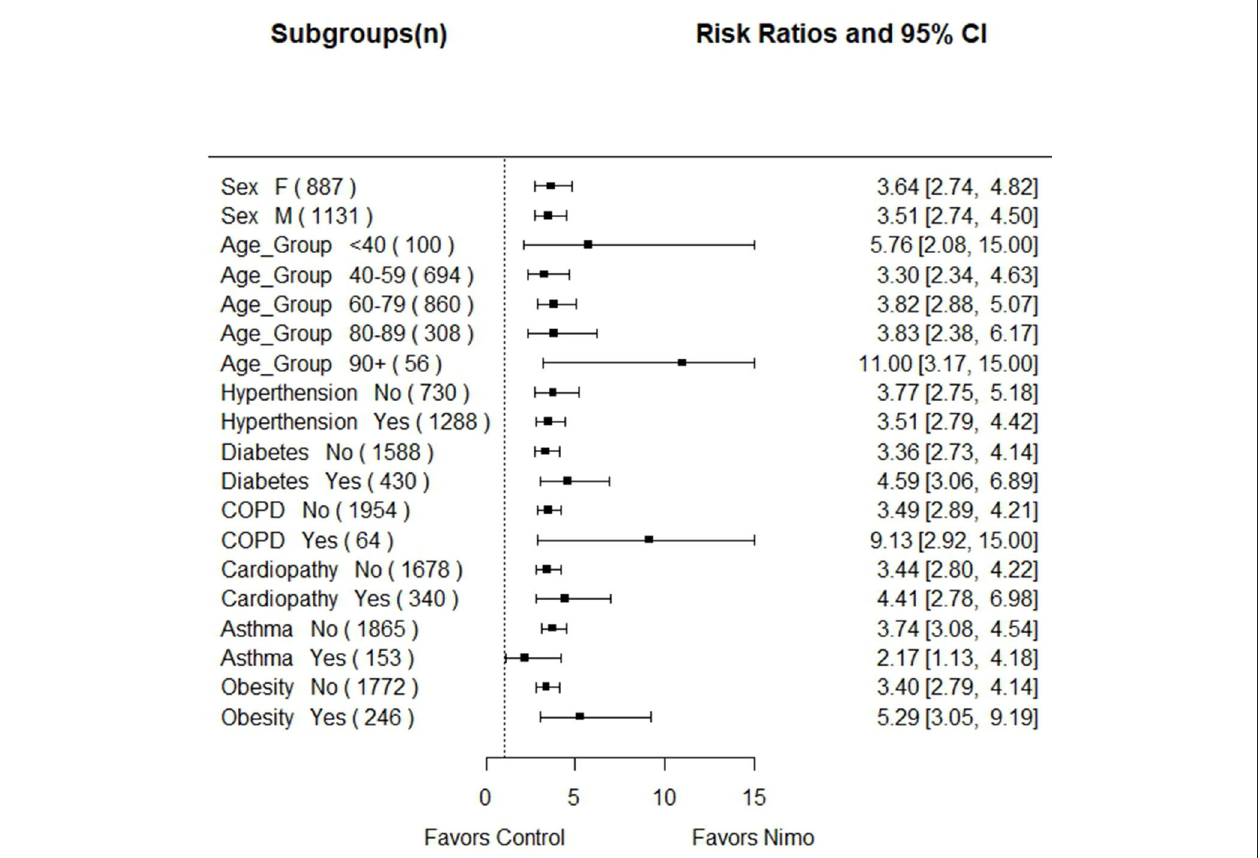
FIGURE 1 | Forest plot showing the mortality risk of the control vs. nimotuzumab treated patients according demographics and comorbidities. In all subgroups, the probability of death was significantly higher in non-nimotuzumab treated